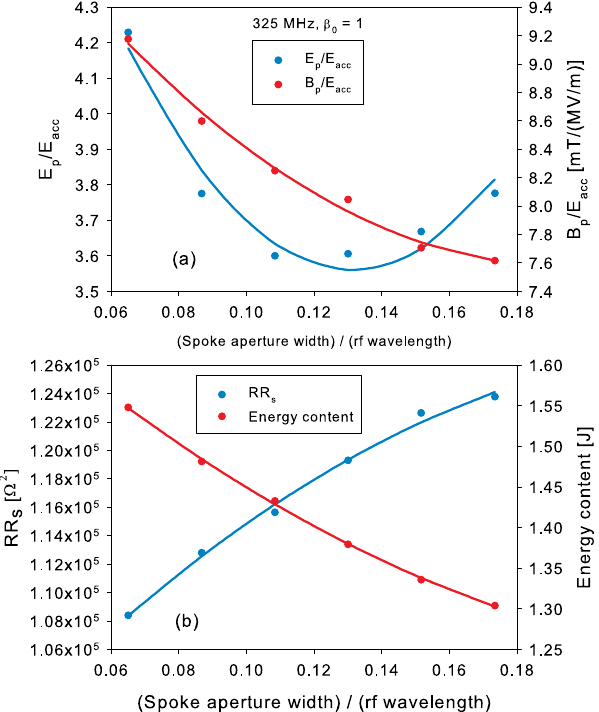
FIG. 16. Dependence of (a) E p =E acc and B p =E acc and (b) RR s and energy content (at 1 MV = m ), on the spoke aperture width.